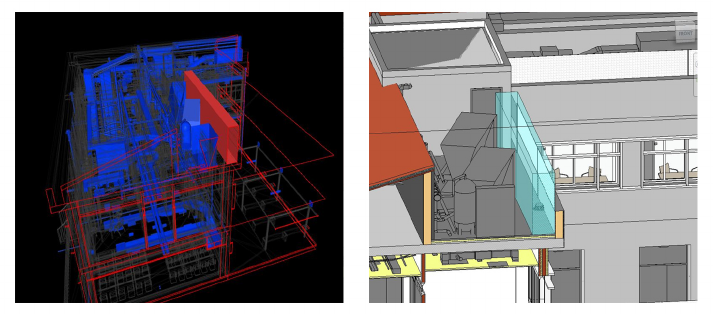
Figure 1. Example of problems detected in the previous phase of a construction